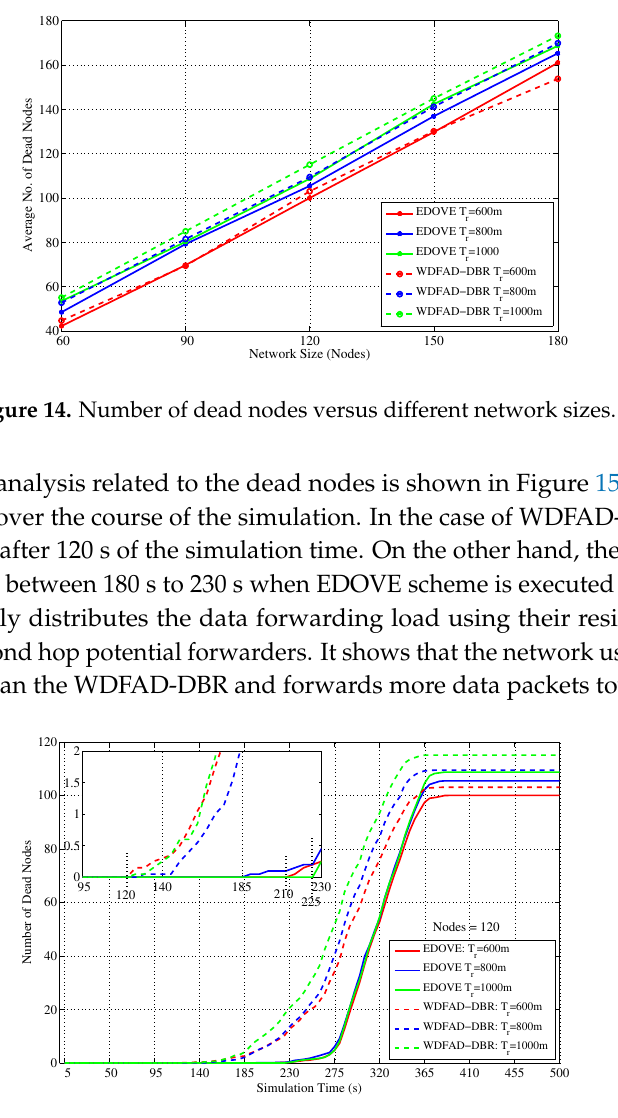
Figure 15. Number of dead nodes during simulation duration for the fixed transmission range and different network